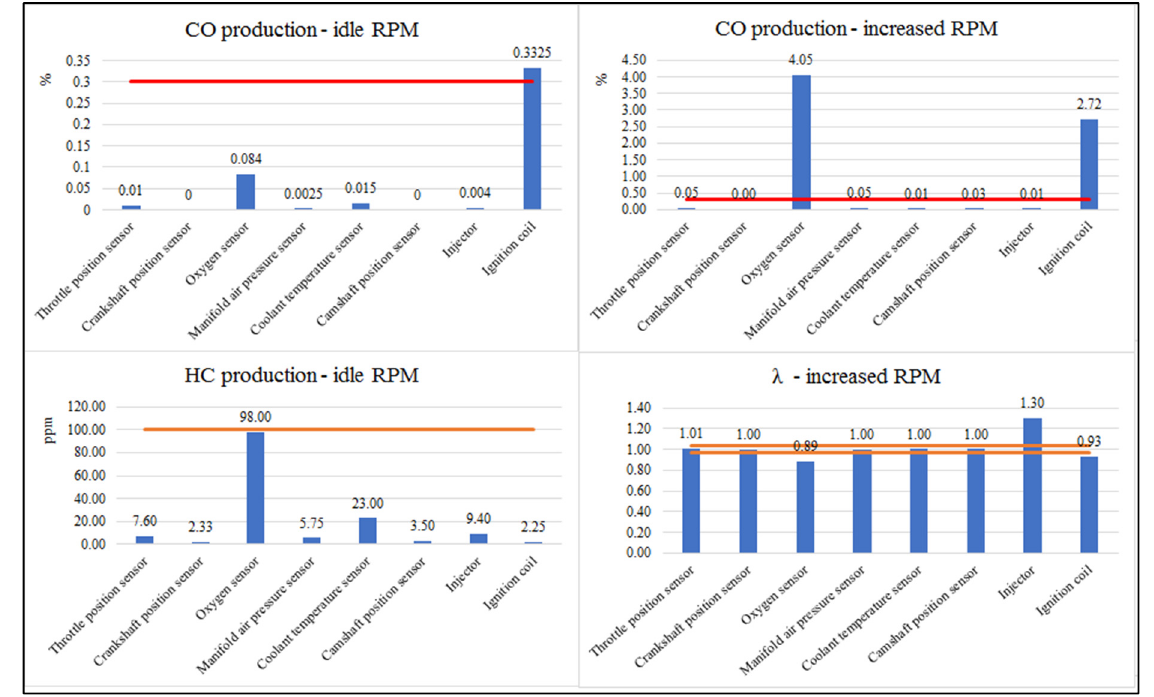
Figure 5. Graphic course of monitored emissions (author).